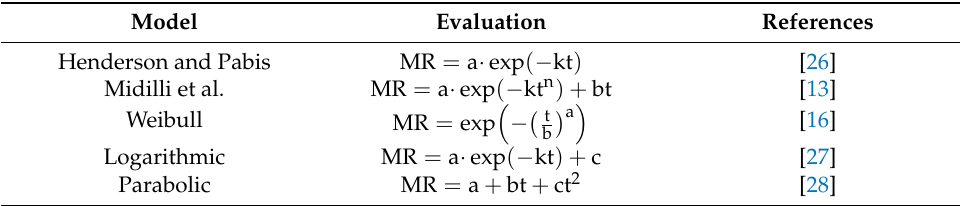
Table 1. Commonly used mathematical models of drying.